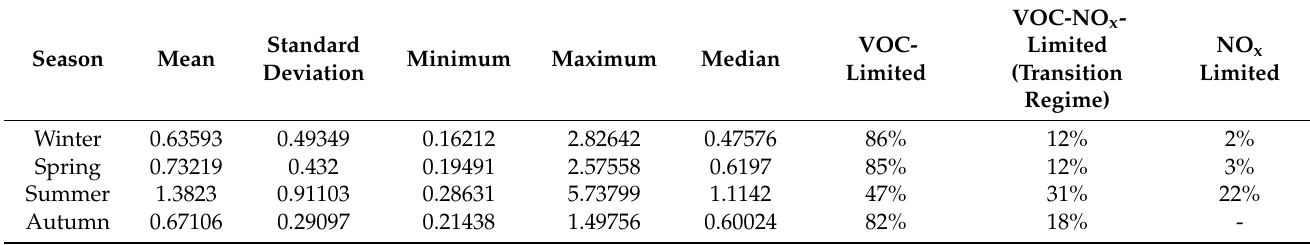
Table 2. Seasonal variation in RFN calculated for the analysis of O 3 sensitivity.